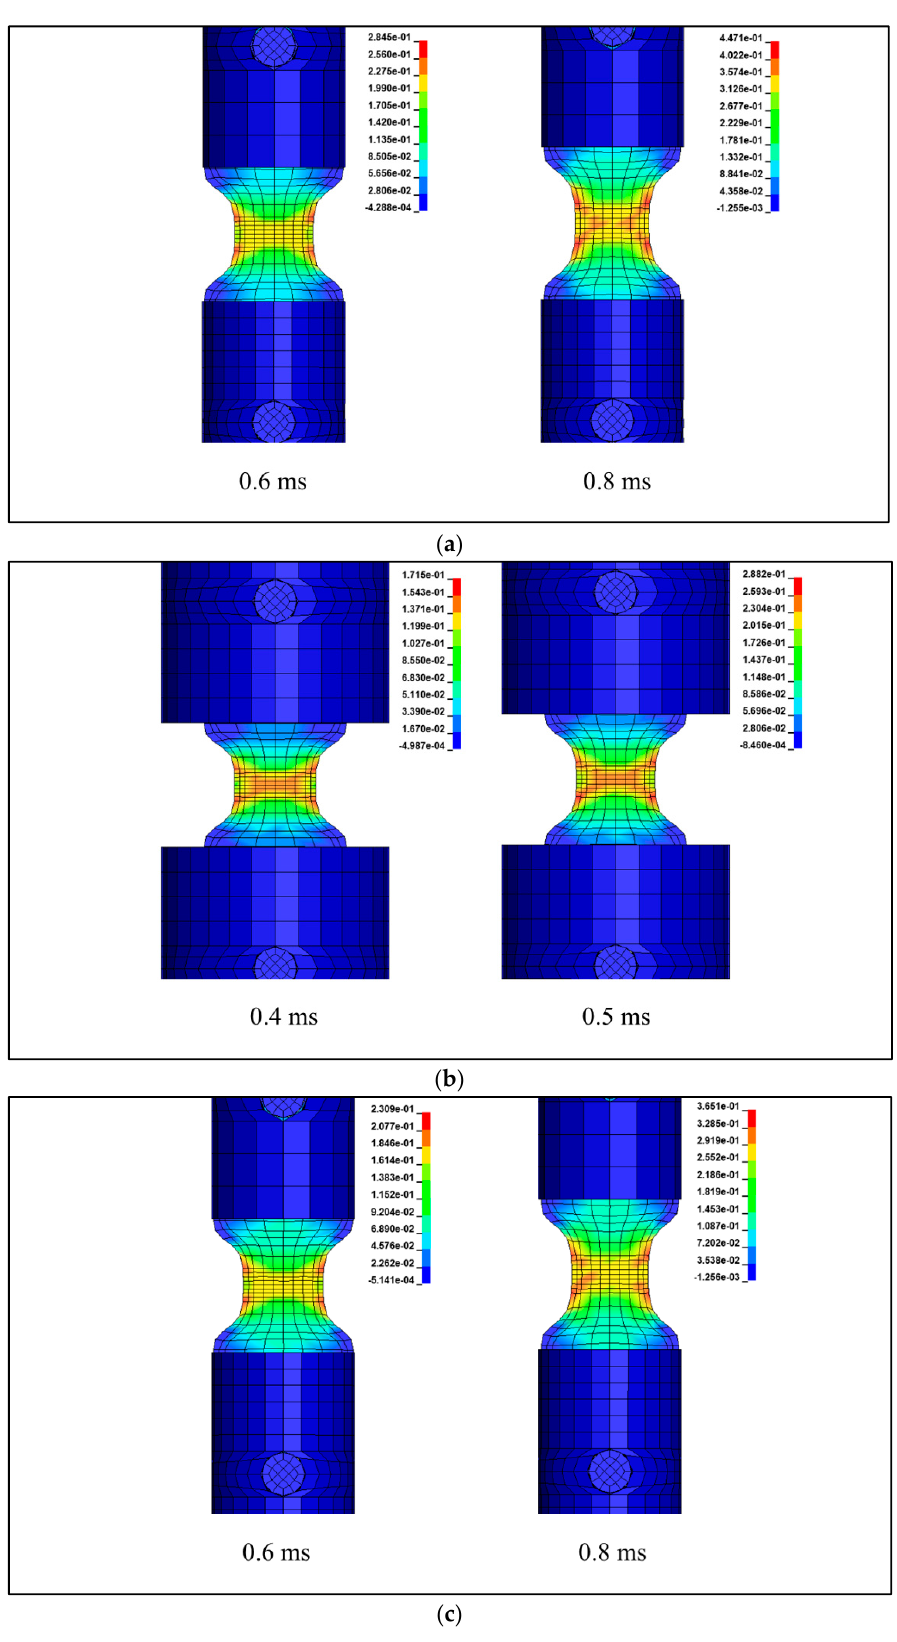
Figure 14. Effective strain distribution of ( a ) aluminum, ( b ) steel, and ( c ) copper. Figure 14. E ff ective strain distribution of ( a ) aluminum, ( b ) steel, and ( c )